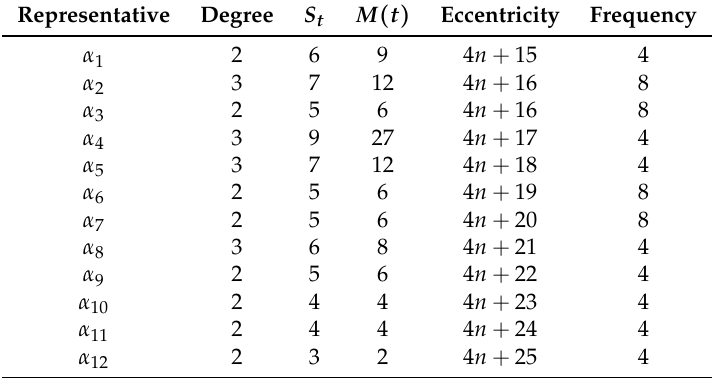
Table 1. The set of representatives of the core with their degrees, S t , M ( t ) , eccentricities and frequencies.